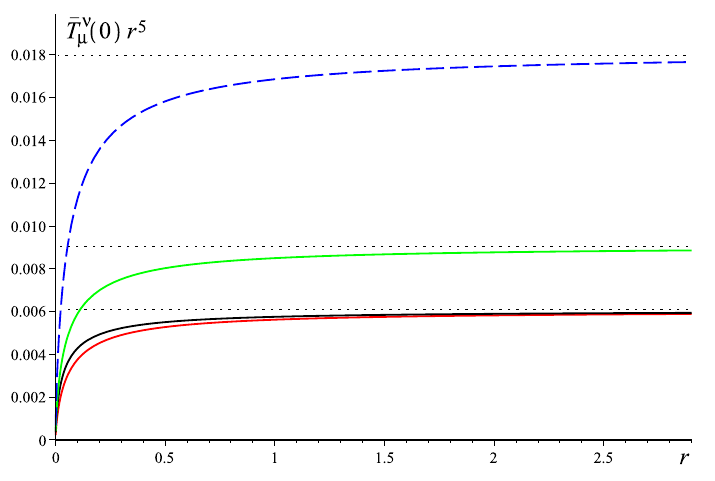
Figure 5. Plots of the conformal part of (cid:104) T ν µ (cid:105) ren (normalized by the overall factor r 6 ) for α = 1: ˜ T t (red), ˜ T r r (black), and − ˜ T ϕ ϕ (green). Horizontal asymptotes at r → ∞ and their ratio correspond to Equation(54).